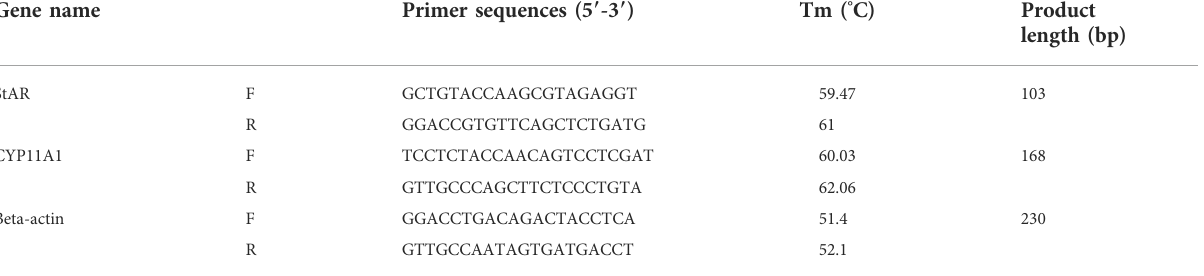
TABLE 1 Primer sequences used for